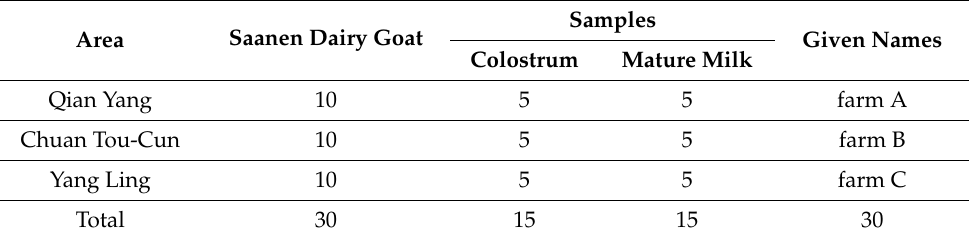
Table 1. Information of selected colostrum and mature milk